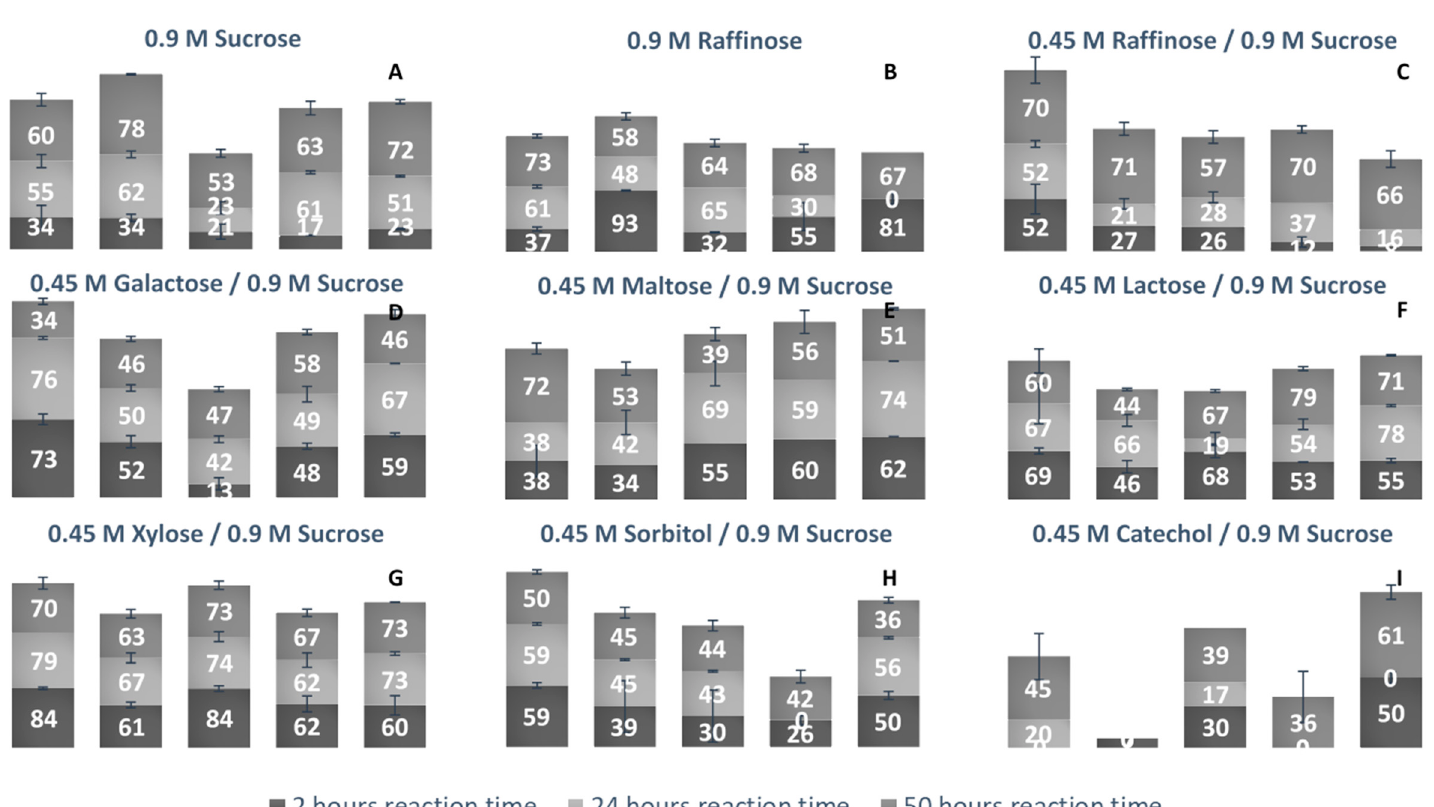
Figure 10. Percent bioconversion of various monosaccharides, disaccharides, and trisaccharides as acceptor/donor molecules by various LSs as a function of time. ( A ) Sucrose (0.9 M) was the sole fructosyl donor and acceptor initially present. ( B ) Raffinose (0.9 M) was the sole fructosyl donor and acceptor initially present. ( C ) Raffinose (0.45 M), in the presence of sucrose (0.9 M) were the initial substrates (both available to act as fructosyl donor/acceptor molecules). ( D ) Galactose, ( E ) Maltose, ( F ) Lactose, ( G ) Xylose, ( H ) Sorbitol and ( I ) Catechol (0.45 M) were present to act as a fructosyl acceptors in the presence of sucrose (0.9 M). Column 1: LS from V. natriegens ; column 2: LS from G. oxydans ; column 3: N. aromaticivorans ; column 4: LS from P. graminis ; column 5: B. indica subsp. indica . Numbers listed on columns represent the percentage of carbohydrate acceptor consumed at that given reaction time.